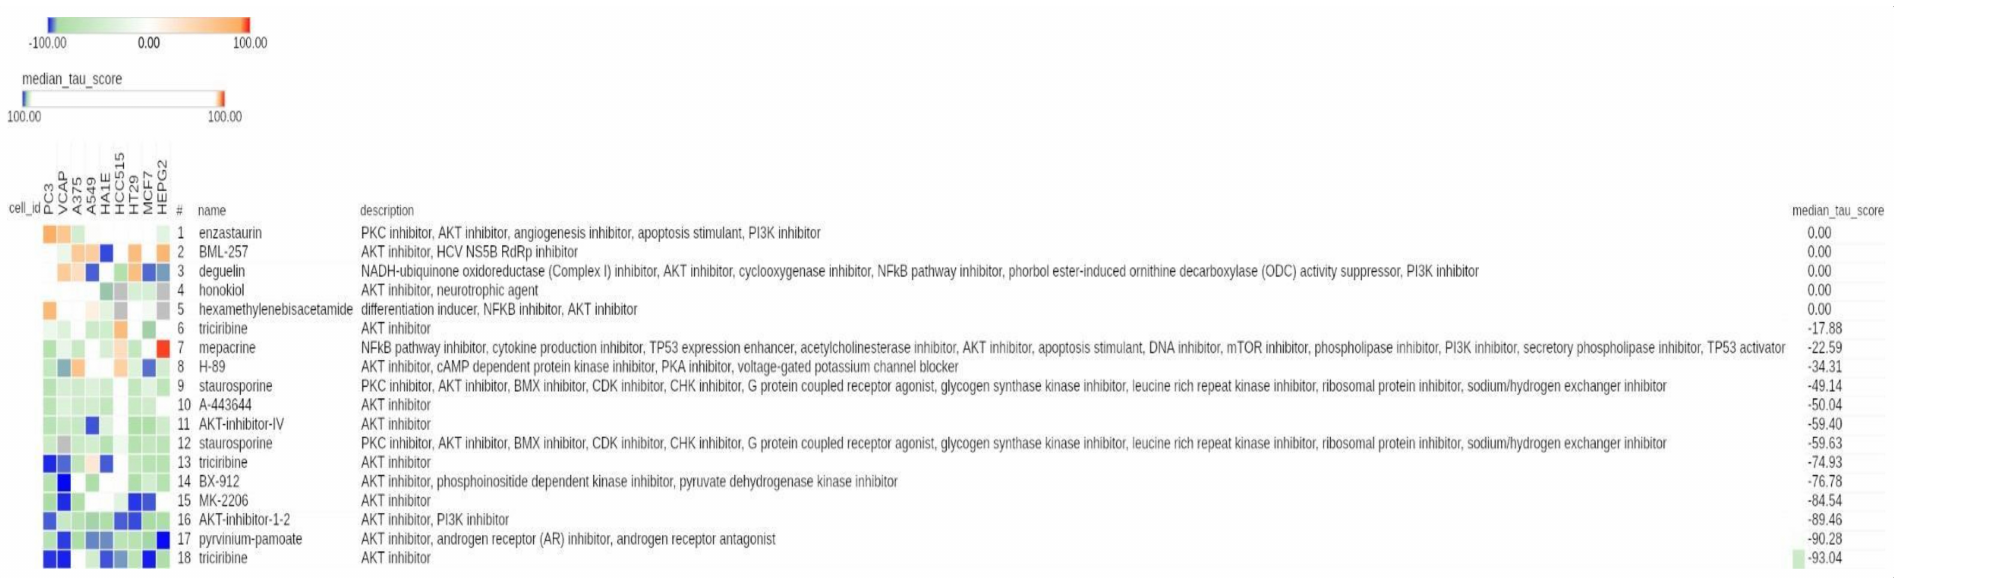
Figure 4. CMap results related to AKT inhibitors in the entire CMap reference database. Heat map showing the connectivity score between each cell line (columns) and compound (rows). The heat map was generated using the CMap tool. Compounds are relative to the class of AKT inhibitors. The numeric identifier, compound name, description and median tau score for each compound are indicated. The cell line identifier is shown on top of the figure. Median tau score measures the strength of connection between a query signature and a drug across multiple cell types. Compounds are sorted by decreasing order of median tau score. Color keys are displayed on top of the